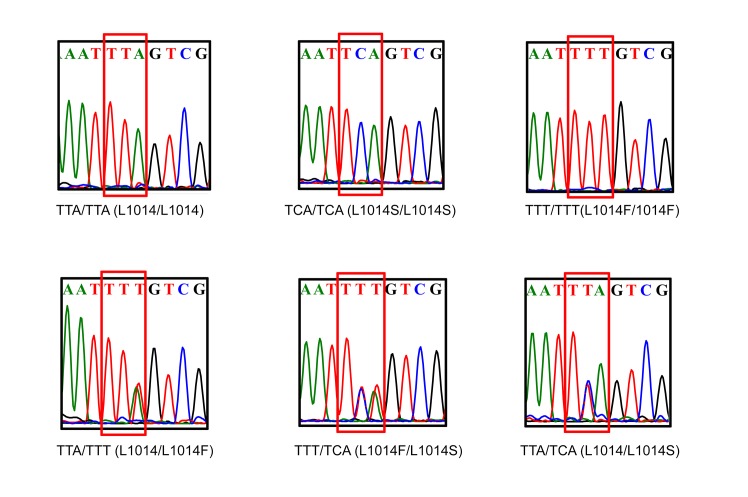
Population kdr genotypes.A total of six genotypes were identified in this Cx. pipiens pallens population: TTA/TTA, TCA/TCA, TTT/TTT, TTA/TTT, TTT/TCA and TTA/TCA. Red box indicates the 1014 site of the kdr gene.